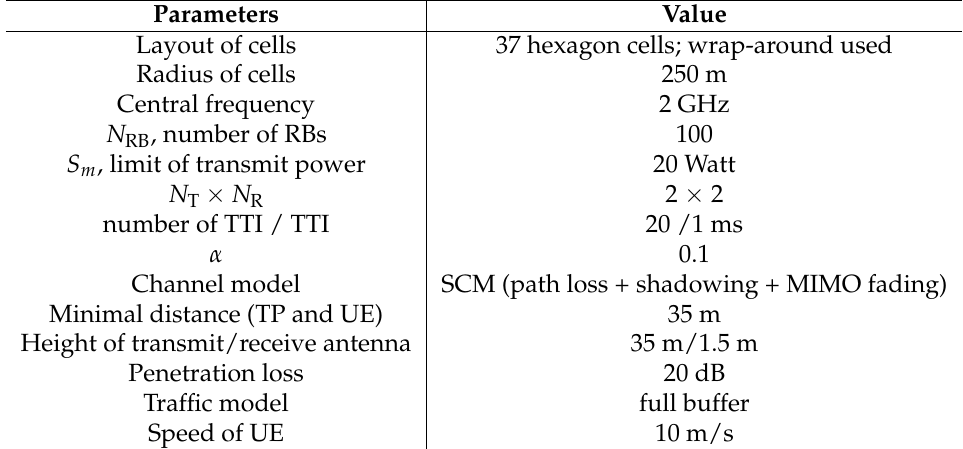
Table 2. Parameters in the